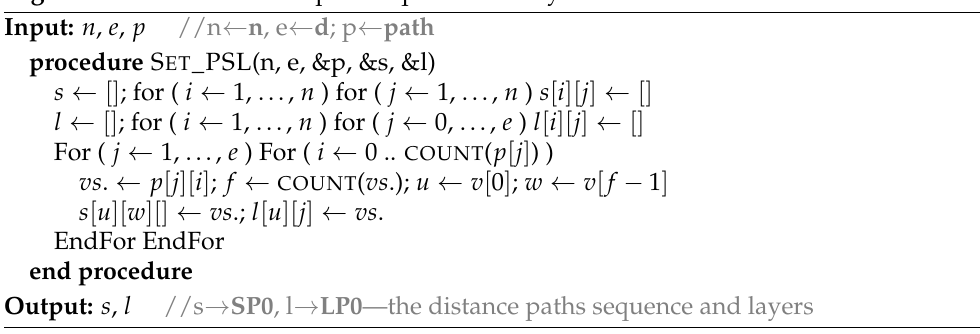
Algorithm A15 Set cycle sequence and layers.